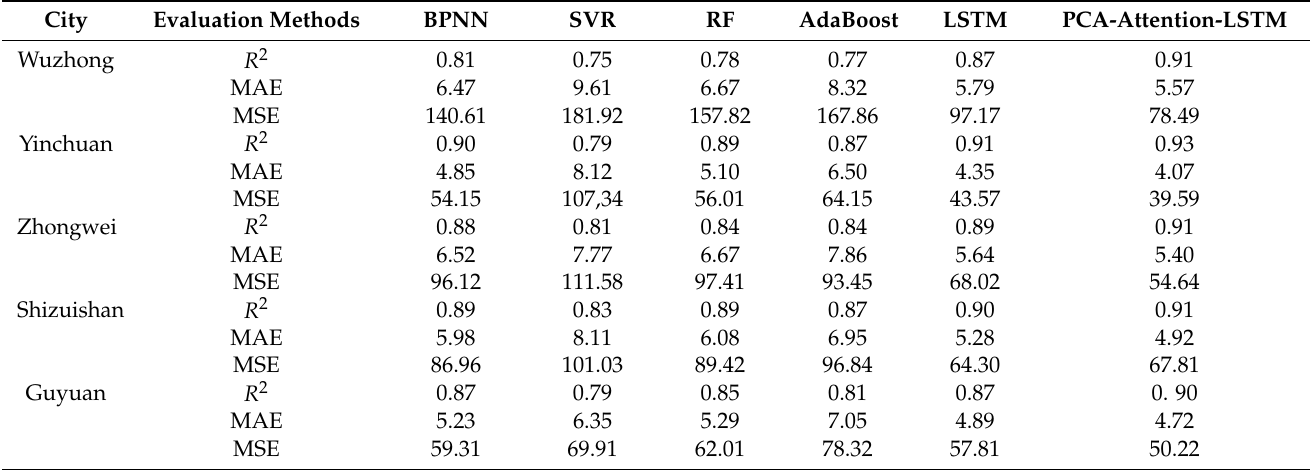
Table 4. Model evaluation